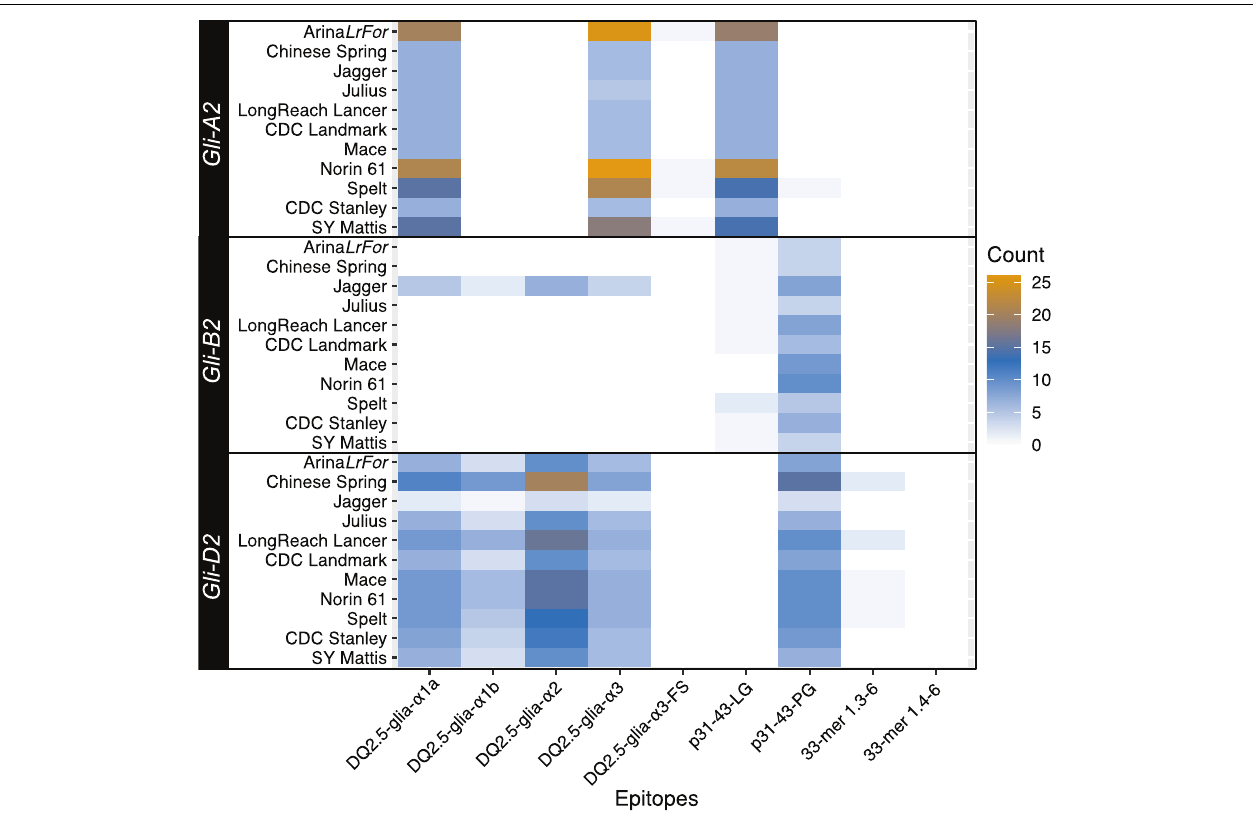
FIGURE 2 | Celiac disease (CD) epitope quantification within α -gliadin copies. The frequency of canonical CD epitopes varies between accessions and homoeologous